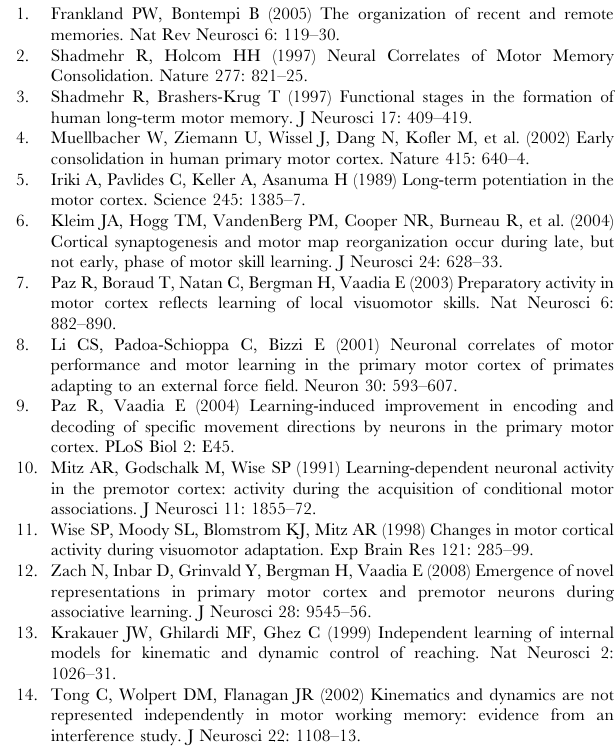
Figure S2 Directional representation before and after arbitrary association. SNR change for different movement